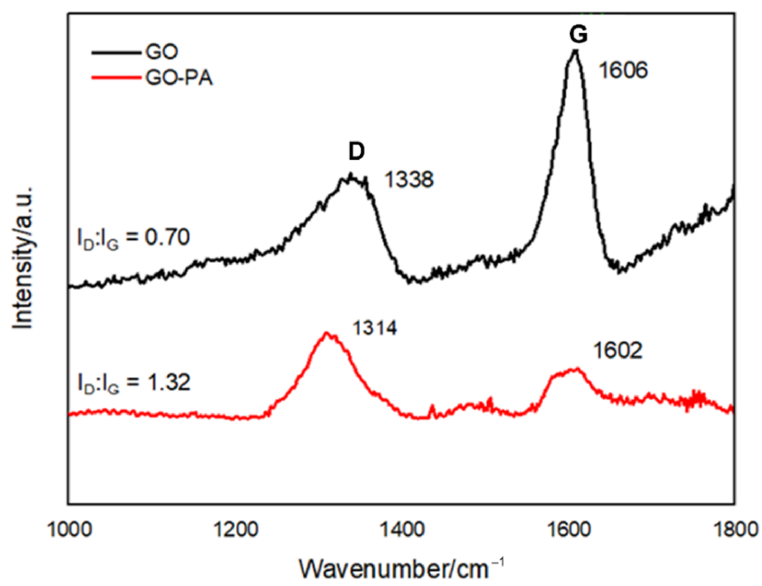
Figure 7. Raman spectra of GO and GO-PA nanofillers reporting the D and G peaks intensity ratio, respectively.